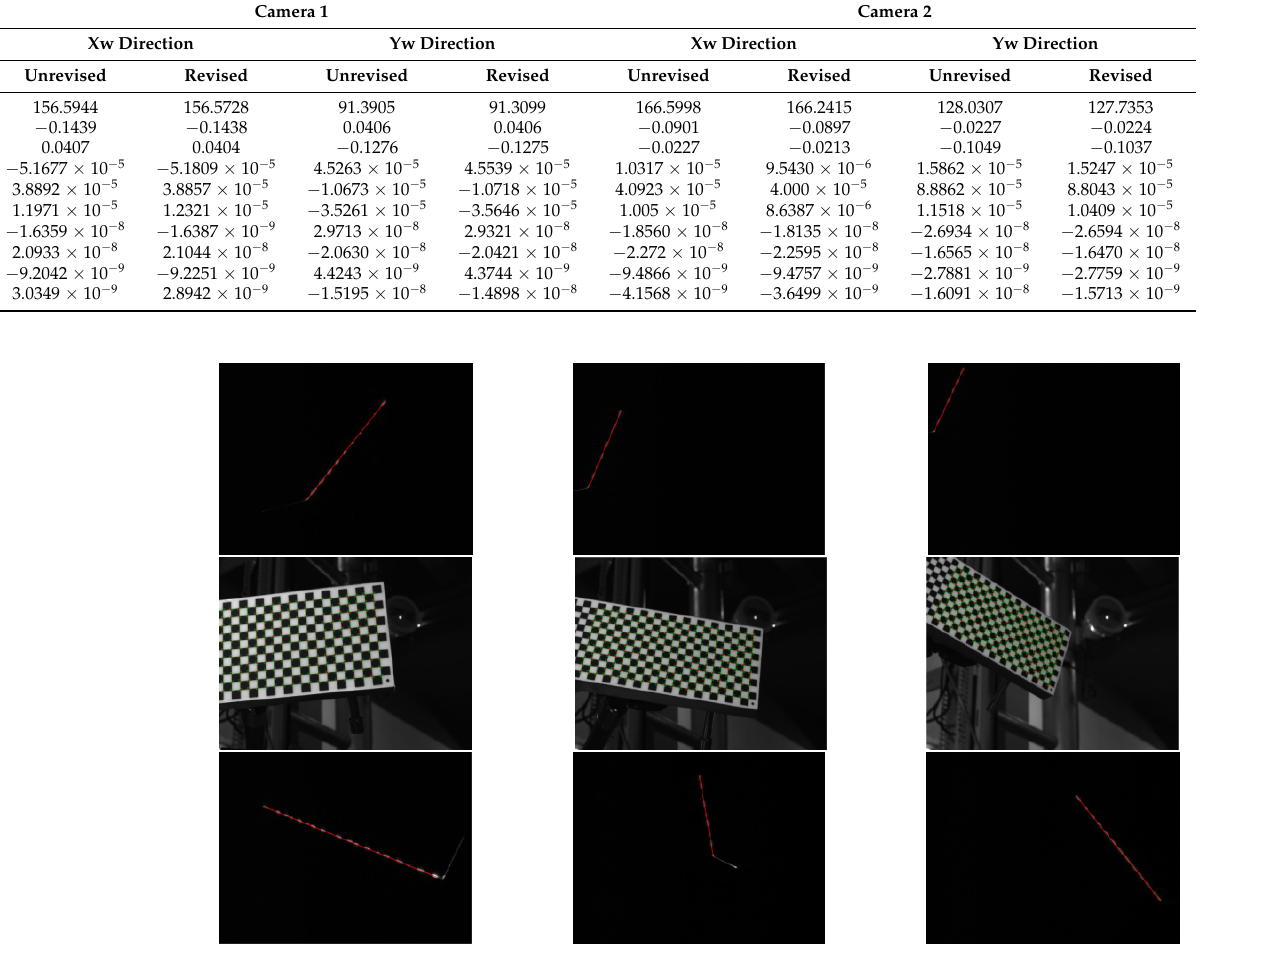
Figure 12. Images used for calibration in the second experiment. Figure 13. The extrinsic parameters and the fitting laser plane (red) in the second experiment.